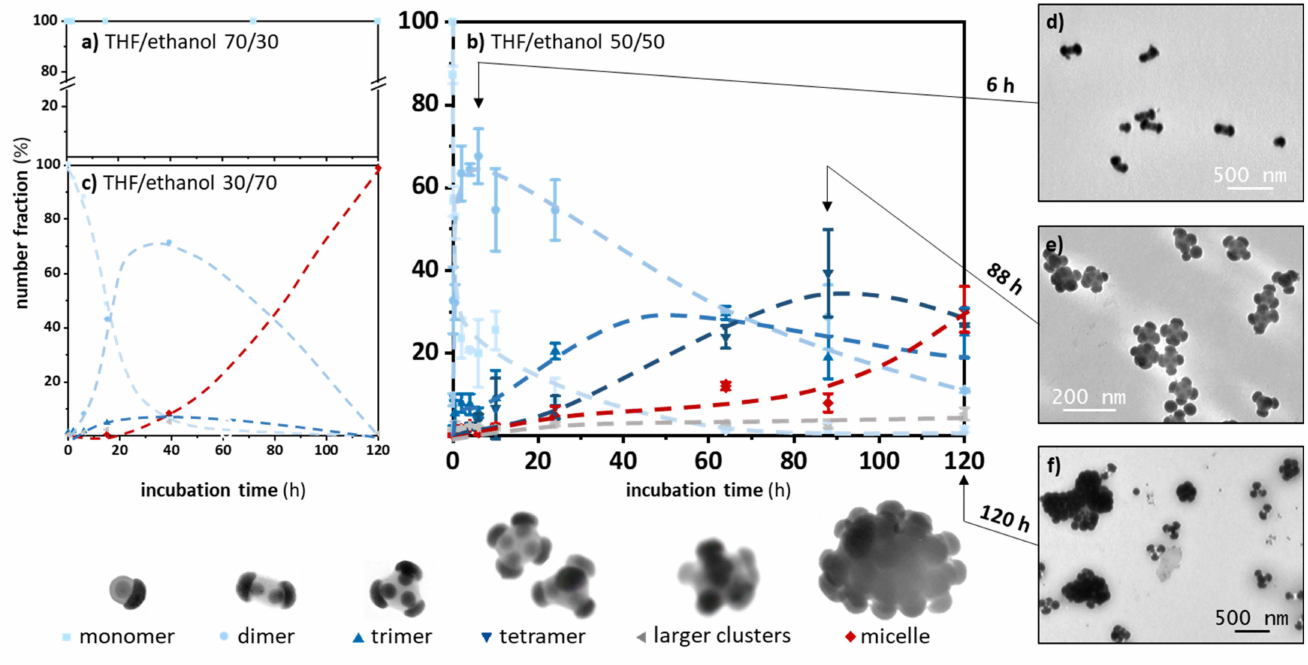
Figure 3. Evolution with the incubation time of the number distribution of silica monomers (S = 0.87), dimers, trimers, etc., as determined by the statistical analysis of the TEM images for different fractions of ethanol in the THF/ethanol mixture: ( a ) 30 vol%; ( b ) 50 vol%; and ( c ) 70 vol% (the dotted curves are only guides for the eyes). Experimental conditions: silica particle concentration, 1.8 × 10 14 L − 1 ; temperature, 20 ◦ C. The representative TEM images of the silica particles present in the incubation medium after 6 h ( d ), 88 h ( e ), and 120 h ( f ) corresponding to some of the samples collected for building the graphs in ( b